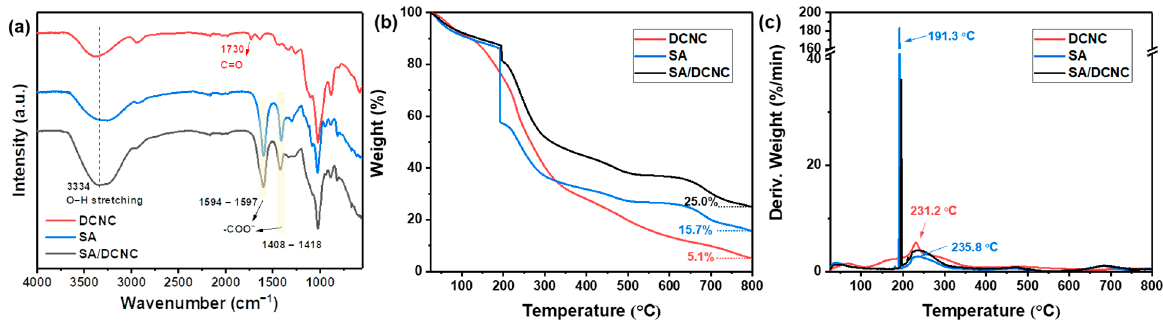
Figure 7. ( a ) FT ‐ IR spectra, ( b ) TGA, and ( c ) DTG curves of SA, DCNC, and SA–DCNC ‐ 40. Figure 7. ( a ) FT-IR spectra, ( b ) TGA, and ( c ) DTG curves of SA, DCNC, and